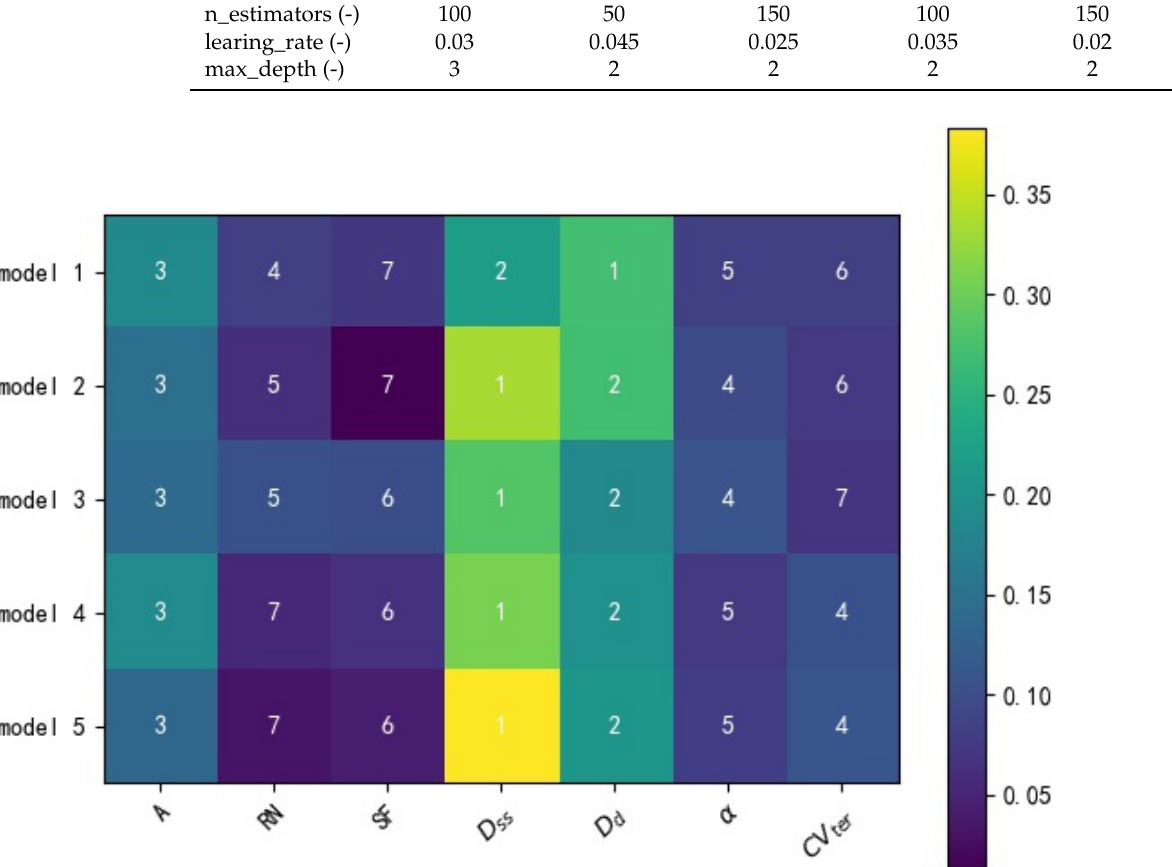
Figure 4. Important level of different predictors evaluated by five GBRT models with yellow repre- senting the largest importance index. Shown also is the sorted importance of different predictors with 1 corresponding to the most important